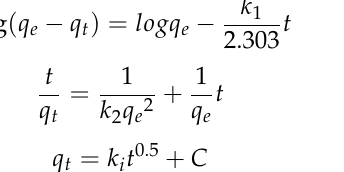
Table 3. Adsorption kinetic parameters for the adsorption for MB adsorption.